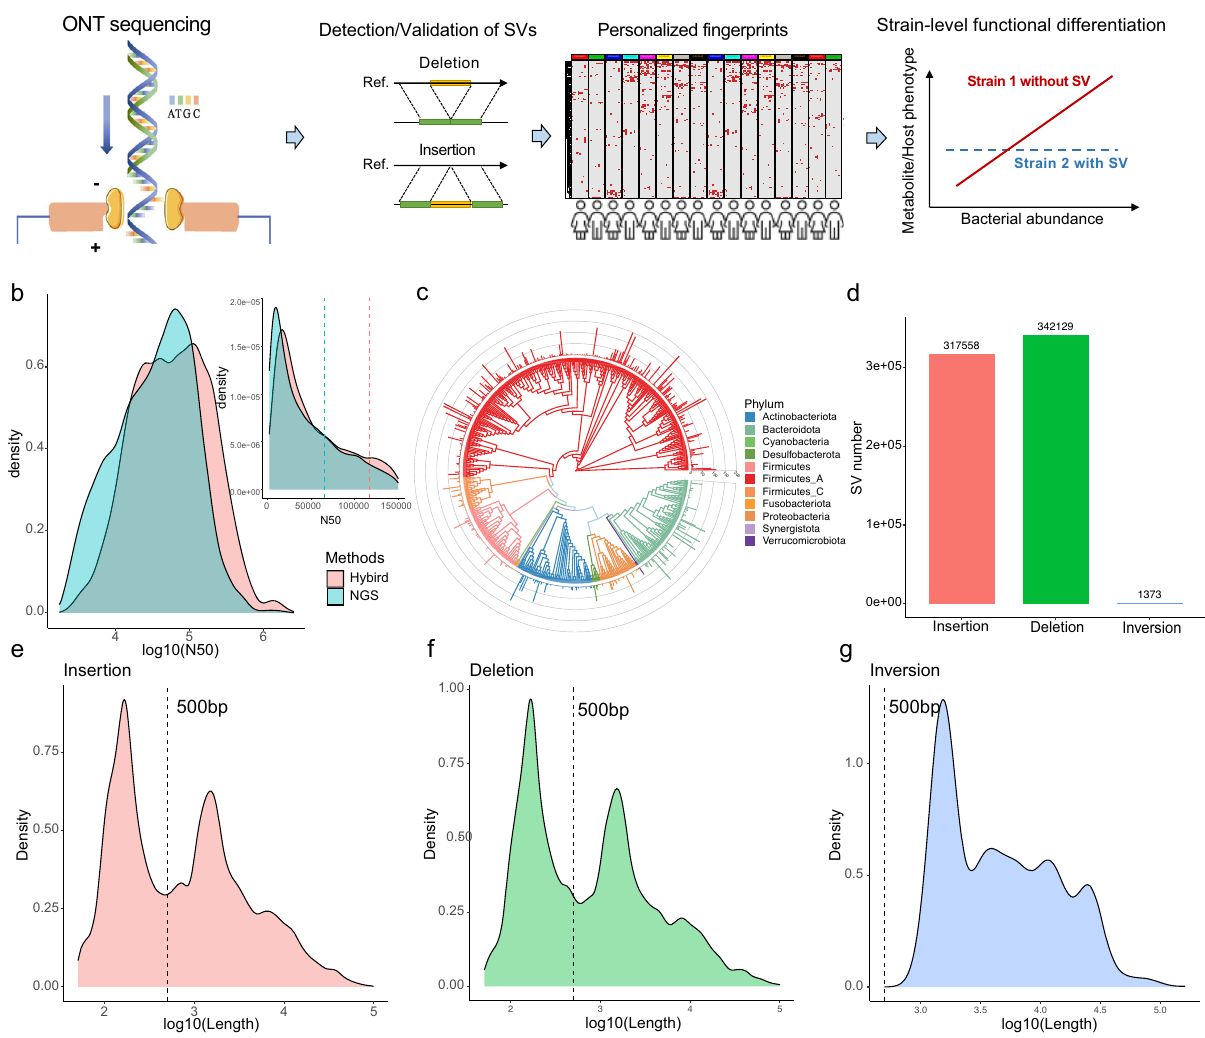
Fig. 1 ONT reads improved metagenomic assembly, empowered structural variations (SVs) detection and validations. a Schematic representation of work fl ow of this study. Top, utilizing the long reads from ONT we improved metagenomic assemblies in hundreds of gut microbiome, enabled detection of large SVs and notably including insertions and inversions, which are highly personalized gut microbial signatures and complicate the correlations to metabolites or host health indicators. b Distribution of contig lengths for Illumina-only approach (NGS) and hybrid assembly (Hybrid), the full distribution is shown in log-scale in the main graph; and part of the detailed distribution is shown in upper right panel including dash lines showing the mean N50 values for binned metagenome-assembled genomes (MAGs) in Illumina-only approach (NGS) and hybrid (Hybrid) assembly. c Phylogenetic distribution of 692 MAGs binned from 200 gut microbiome samples using hybrid assembly. Colors denote major phyla of gut microbiome and the lines in the outer circle indicate number of occurrences for that MAGs (species) in the 200 samples. d Total number of insertions, deletions, and inversions discovered for the 189 MAGs (species) with >10 occurrences in our cohort, with one representative MAGs for each MAGs (species) and rest of MAGs compared to that representative (see Methods and Results). e – g show the length distribution of discovered insertions, deletions, and inversions, in particular, large SVs (> 500 bp) accounting for ca. 50% of insertions and deletions, and all inversions. Table 1 Summary of key parameters for hybrid assembly and Illumina-only assembly per sample.